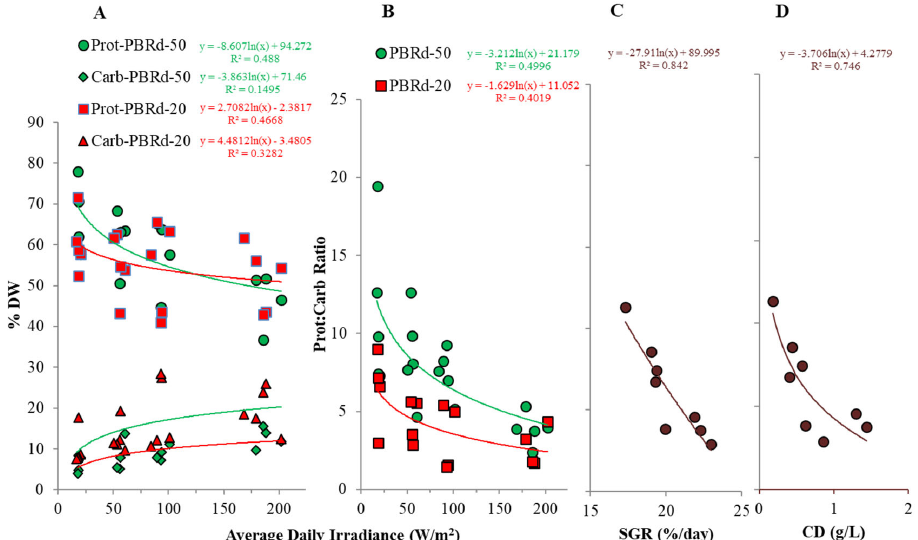
Figure 5. Protein and carbohydrate content of an A. platensis outdoor culture as a function of daily irradiance ( A ), and correlation between the protein: carbohydrate ratio and daily irradiance ( B ), specific growth rate ( C ), and culture density ( D ).